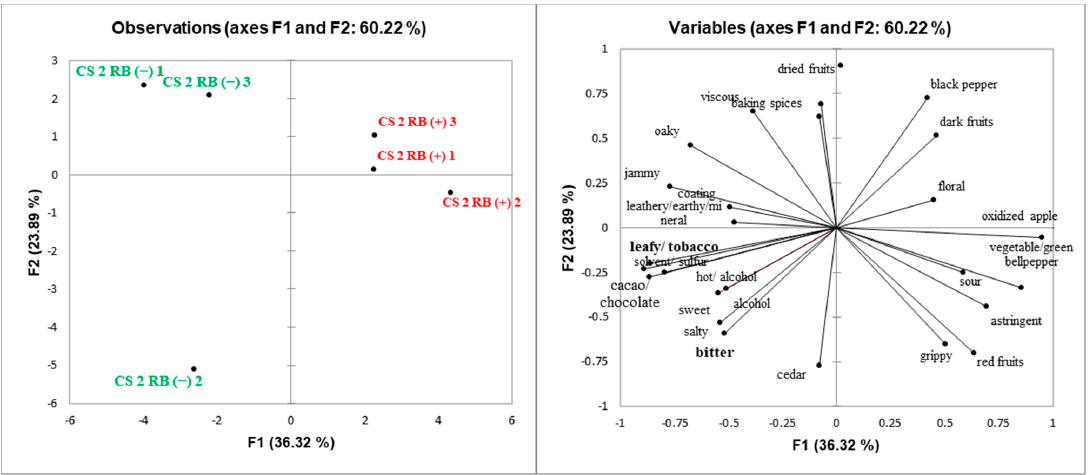
Figure 4. Score (left) and loadings (right) plots of principal component analysis (PCA) of CS2 RB ( − ) and RB (+) 2014 wines. Attributes found to be significantly different by ANOVA ( p < 0.05) are in bold.